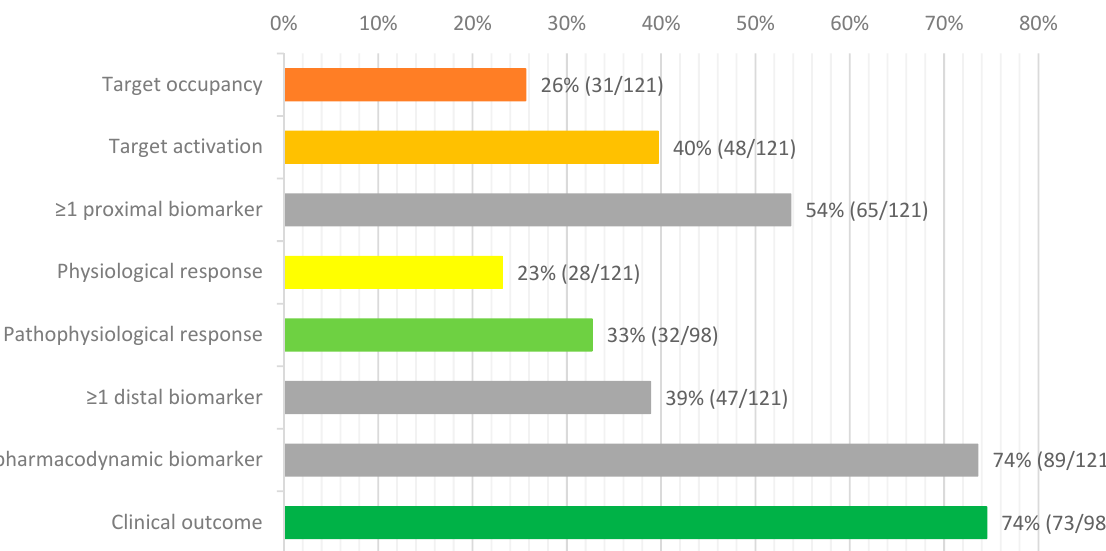
Figure 1. Percentage of early clinical phase reporting the use of different categories of pharmacodynamic biomarkers and clinical outcomes. Thirty-one trials (26%) reported the use of target occupancy biomarkers and forty-eight trials (40%) reported the use of a target activation biomarkers. Sixty-five trials included at least 1 proximal (mechanistic) biomarker (target occupancy and/or activation). Twenty-eight trials (23%) reported the use of physiological response biomarkers. Thirty-two trials used pathophysiological response biomarkers, which comes down to 33% of all early phase NDD DMT trials (98) that were performed in patients. Forty-seven trials (39%) reported the use of at least 1 distal biomarker. In total, 89 of 121 trials reported at least one pharmacodynamic biomarker and seventy-three trials reported clinical outcomes, which comes down to 74% of all early phase NDD DMT trials (98) that were performed in patients.